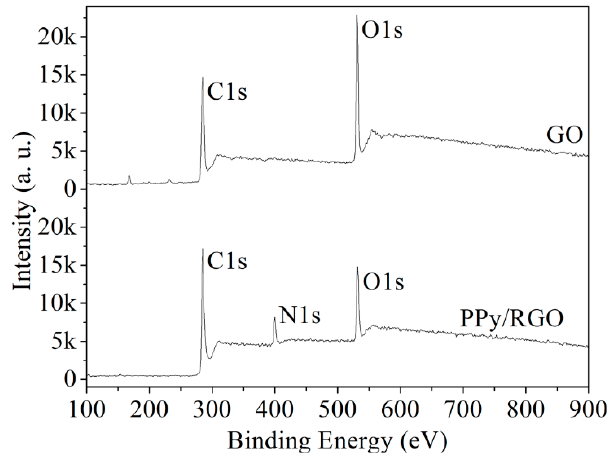
Figure 5. Full electron spectroscope for chemical analysis (ESCA) energy spectrum for GO and PPy/RGO.